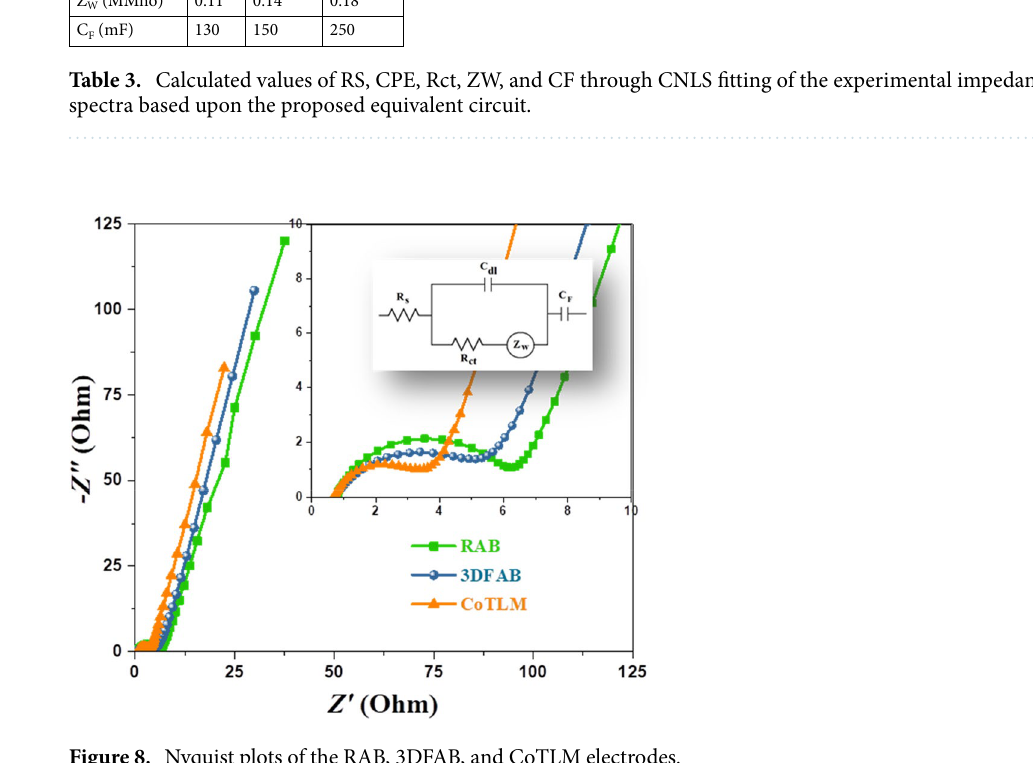
Figure 8. Nyquist plots of the RAB, 3DFAB, and CoTLM